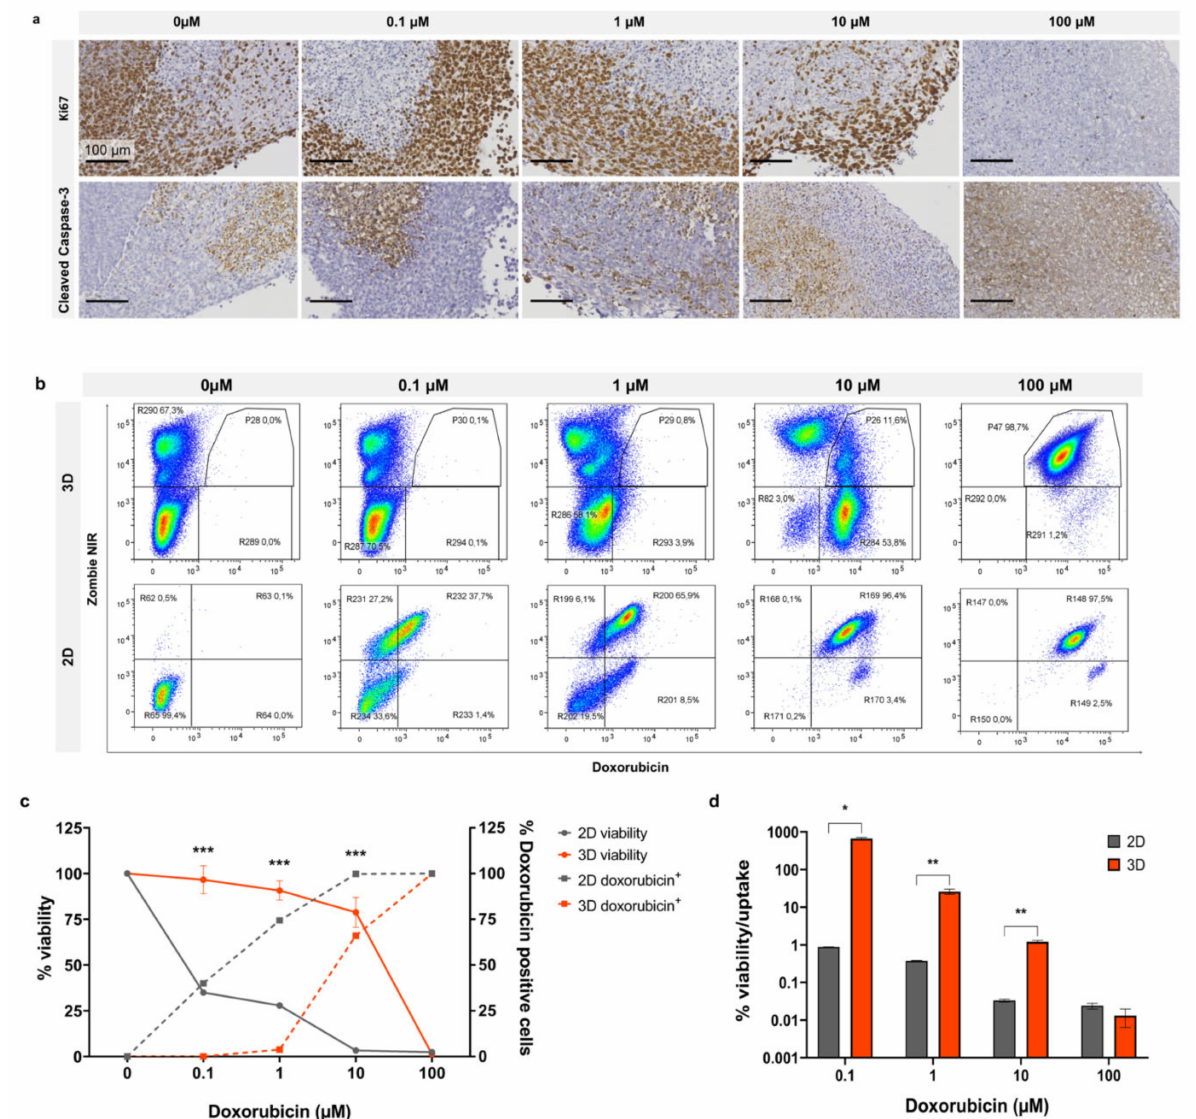
Figure 5. Doxorubicin effect in 2D vs. 3D after 4 days. ( a ) Organotypic slices treated with doxorubicin at scalar doses and stained for Ki67 or cleaved caspase-3. Flow cytometry ( b ), dot plots, and ( c ) line graph of Zombie NIR (viability) and doxorubicin uptake at scalar doses. ( d ) Cell viability as a function of doxorubicin uptake. Graphed data is expressed as Mean ± SD of n = 3 samples. p -values; * p ≤ 0.05, ** p ≤ 0.01, *** p ≤